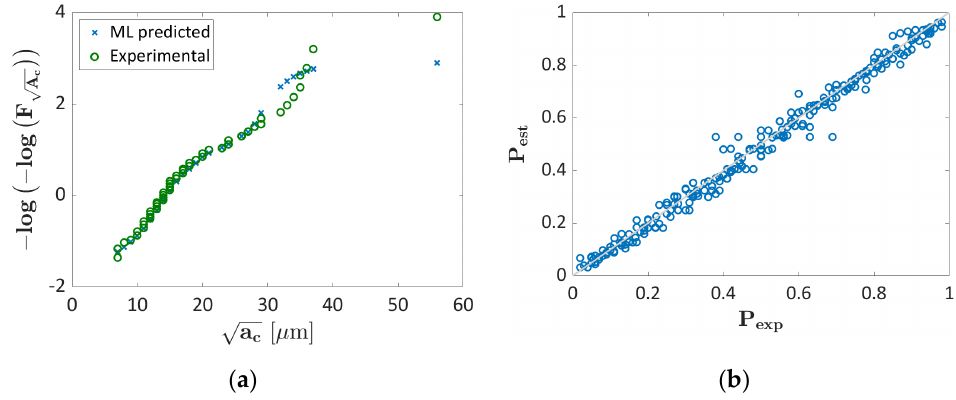
Figure 15. Validation of the investigated Probability ML algorithm: ( a ) Gumbel plot for the validation dataset for k = 3; ( b ) P–P plot for k = 3 by considering the training and the validation data.